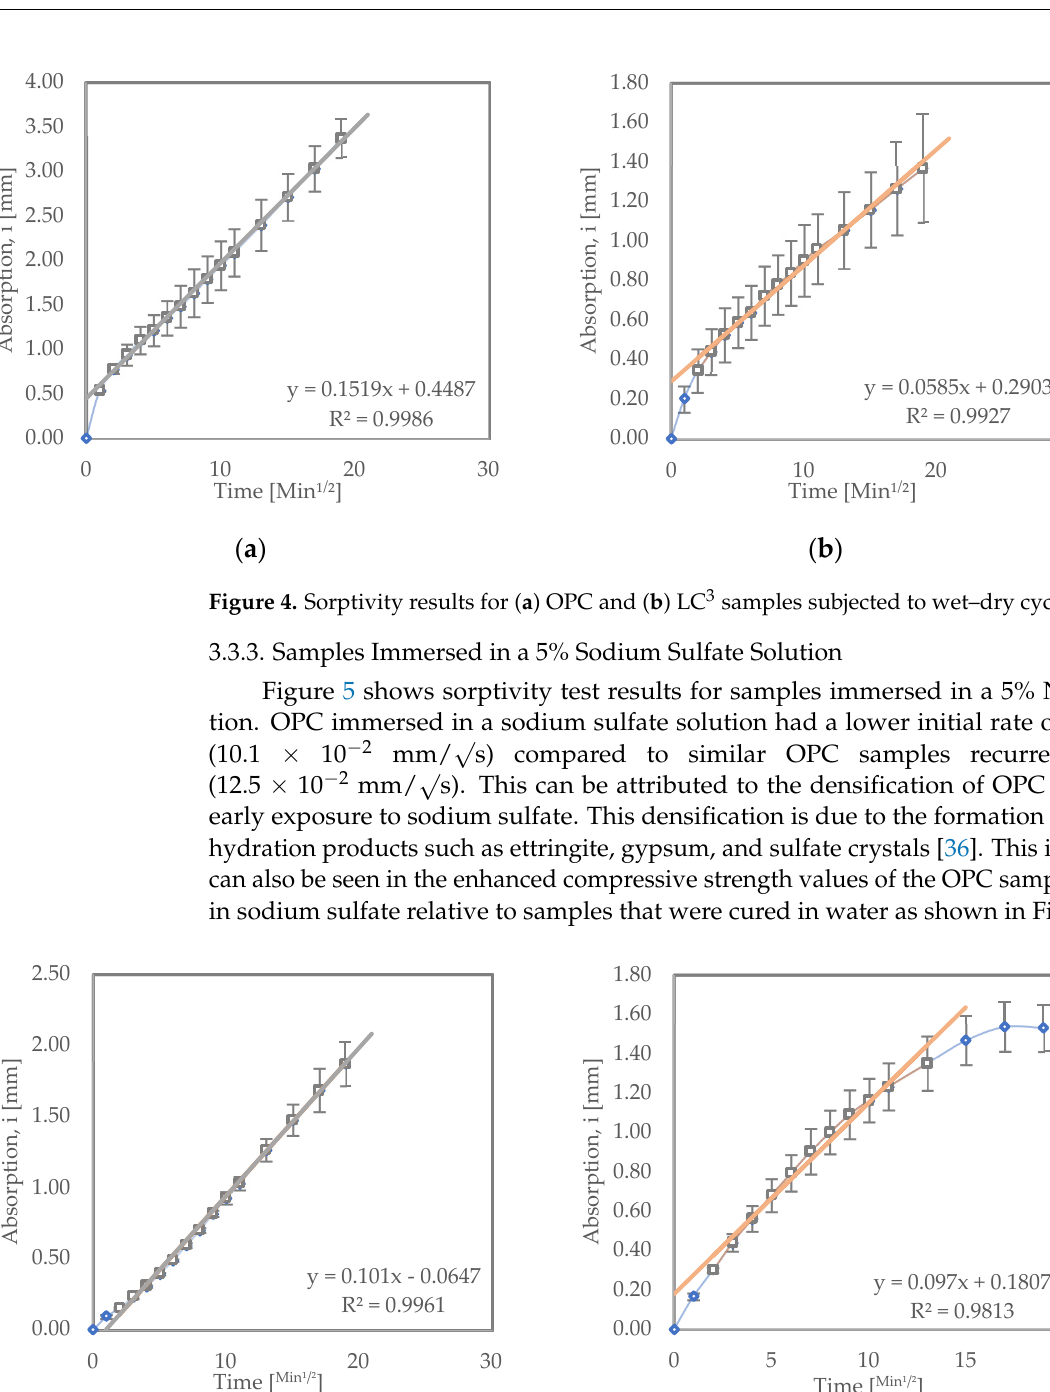
Figure 4. Sorptivity results for ( a ) OPC and ( b ) LC 3 samples subjected to wet–dry cycles.